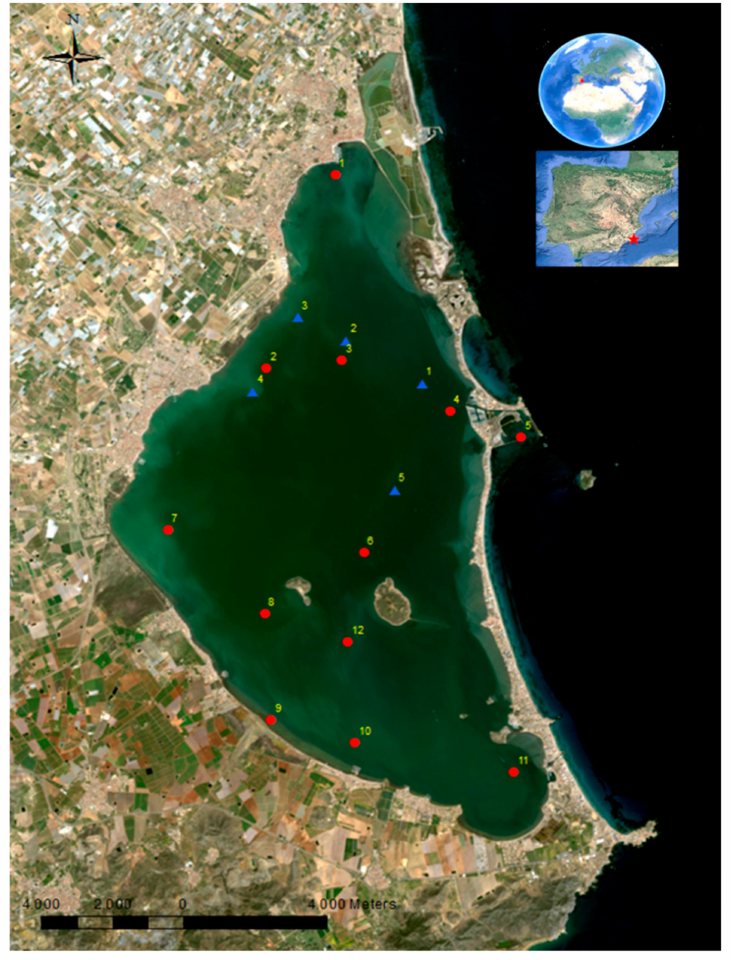
Figure 1. Location of the Mar Menor coastal lagoon, in the Murcia Region of the Iberian Peninsula, and ground-based data: red circles (weekly) and blue triangles (on 2 April